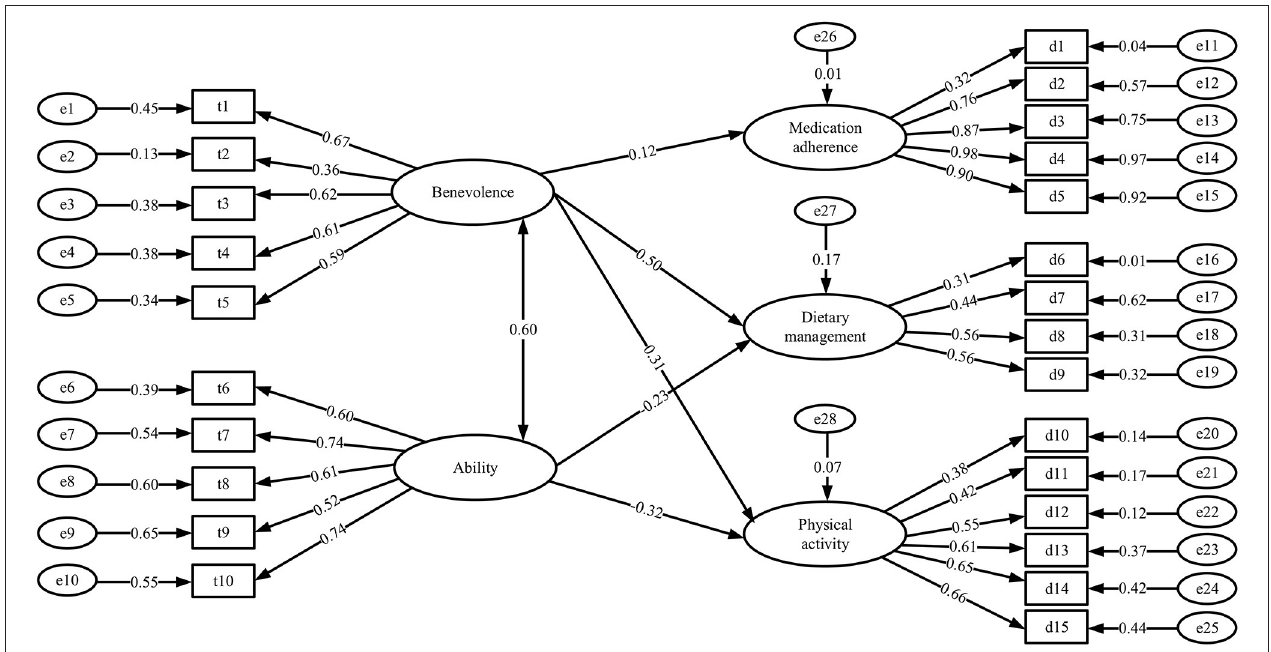
FIGURE 2 | Structural equation model of trust in physicians and patient treatment adherence.